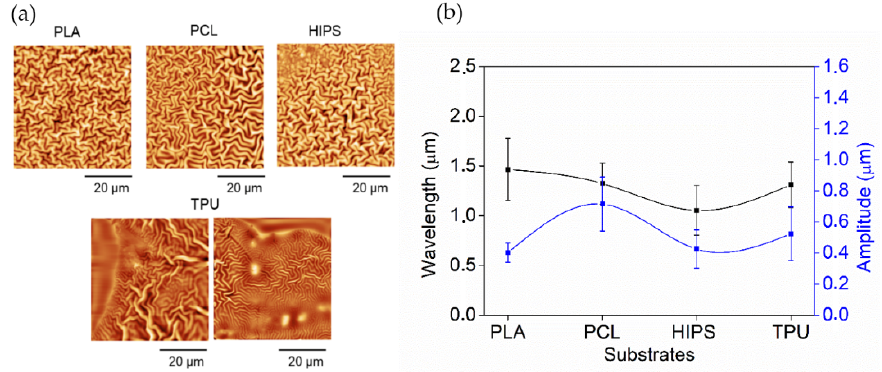
Figure 3. ( a ) AFM micrographs of the wrinkles pattern, using different scaffolds, and ( b ) graph of wavelength (black line) and amplitude (blue line) of the wrinkled patterns.